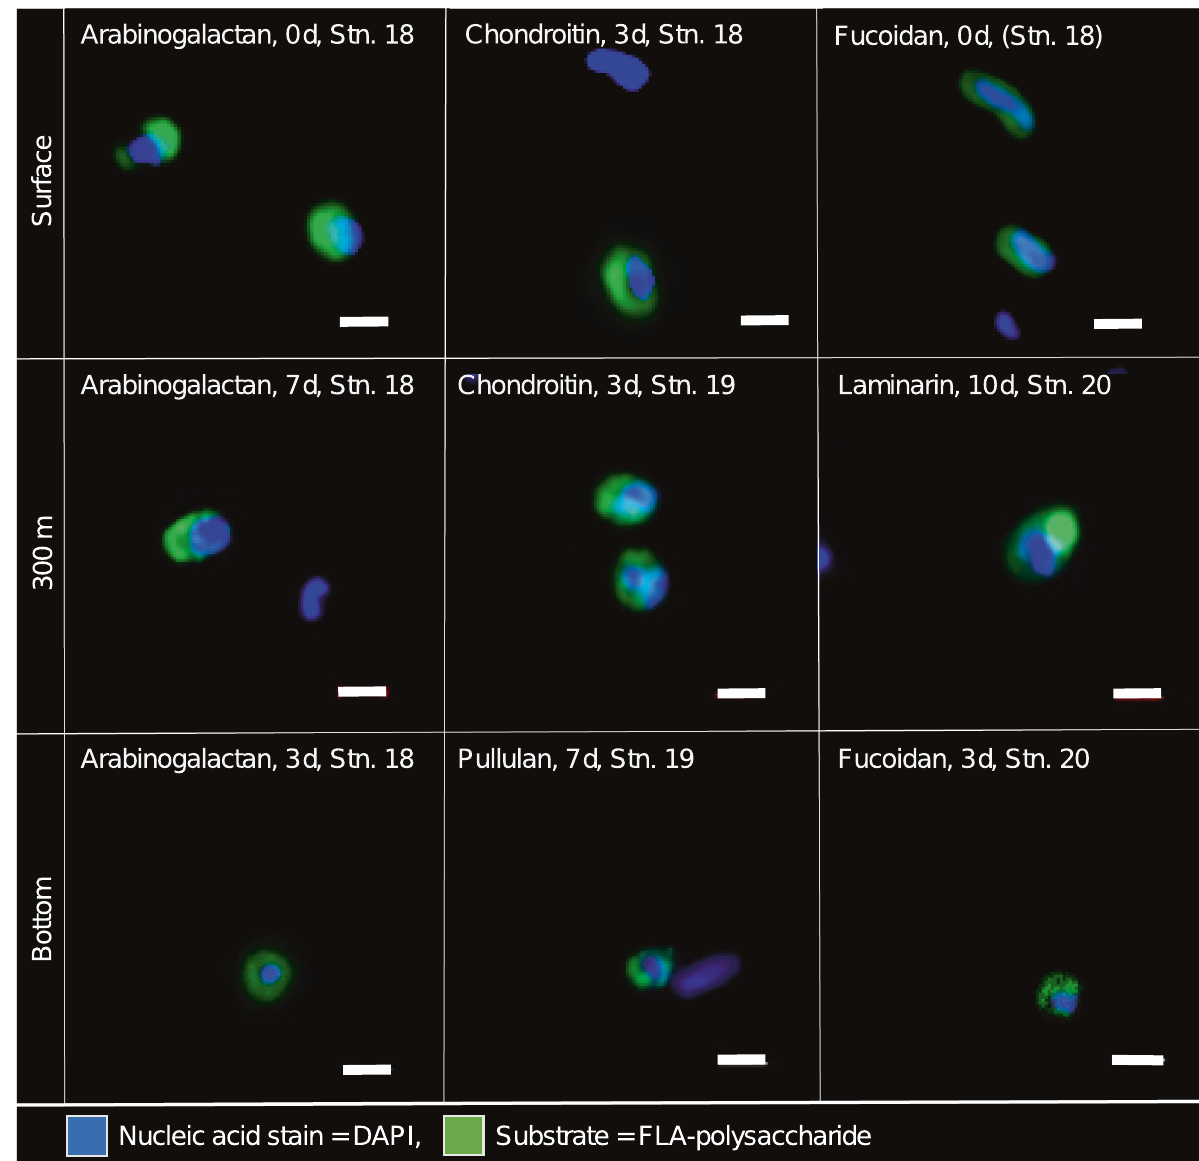
Fig. 1 Sel fi sh bacteria throughout the water column in the western North Atlantic Ocean. Super-resolution images of microbial cells from surface water, 300 m water depth, and bottom water (3 190, 4 325, and 5580 m, at Stns. 18, 19, and 20, respectively) showing accumulation of fl uorescently labeled arabinogalactan, fucoidan, chrondroitin sulfate, laminarin, and pullulan due to sel fi sh uptake. Blue signal (DAPI) shows nucleic acids, green signal is due to fl uoresceinamine-labeled polysaccharides. Scale bar = 1 μ